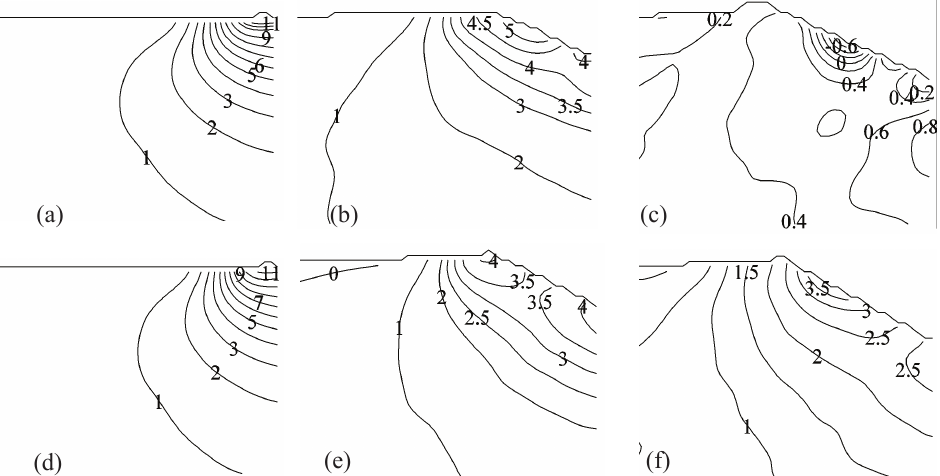
Figure 8. Pressure distribution in the fluid region in kPa for ( a – c ) Light-High and ( d – f ) Heavy-High conditions, at different time instants: ( a , d ) t = 1.25 ms; ( b , e ) t = 7.5 ms; and ( c , f ) t = 12.5